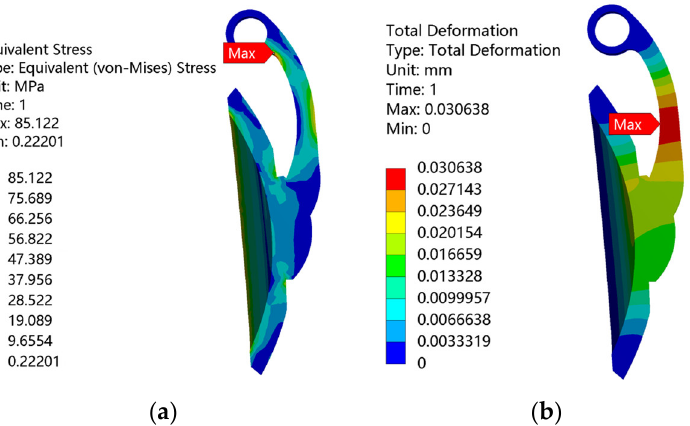
Figure 18. Valve disc stress and deformation distribution under thermal–fluid–mechanical coupling: ( a ) Stress distribution; ( b ) Deformation distribution.